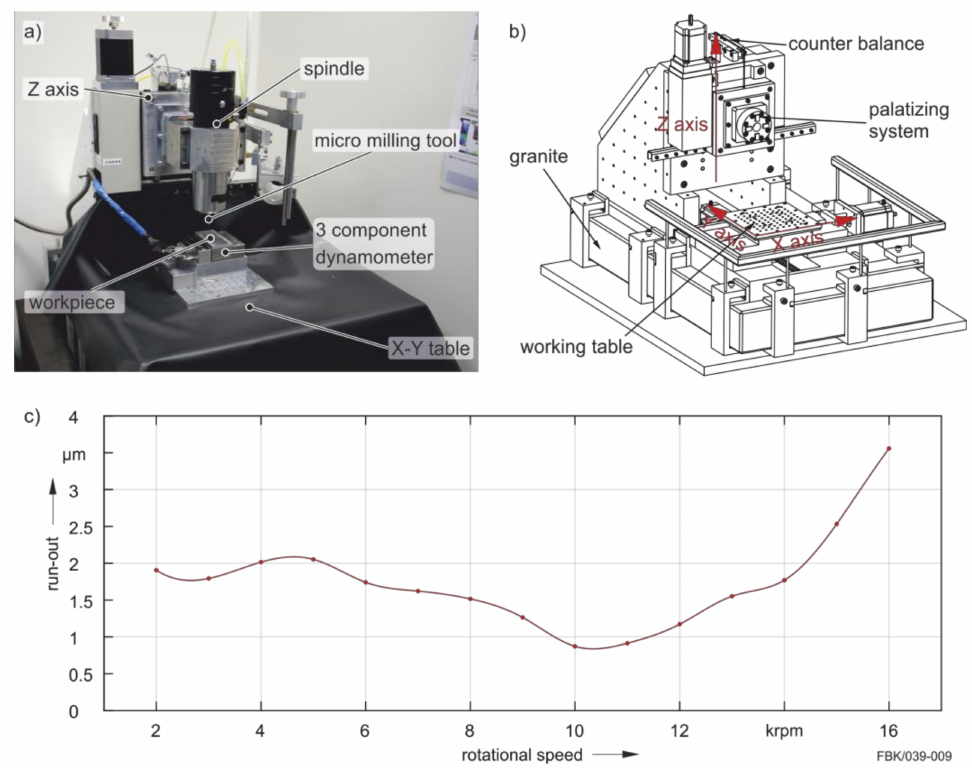
Figure 4. Universal precision machine tool. ( a ) overview, ( b ) isometric view and ( c ) run-out (peak-to-peak) of the air bearing